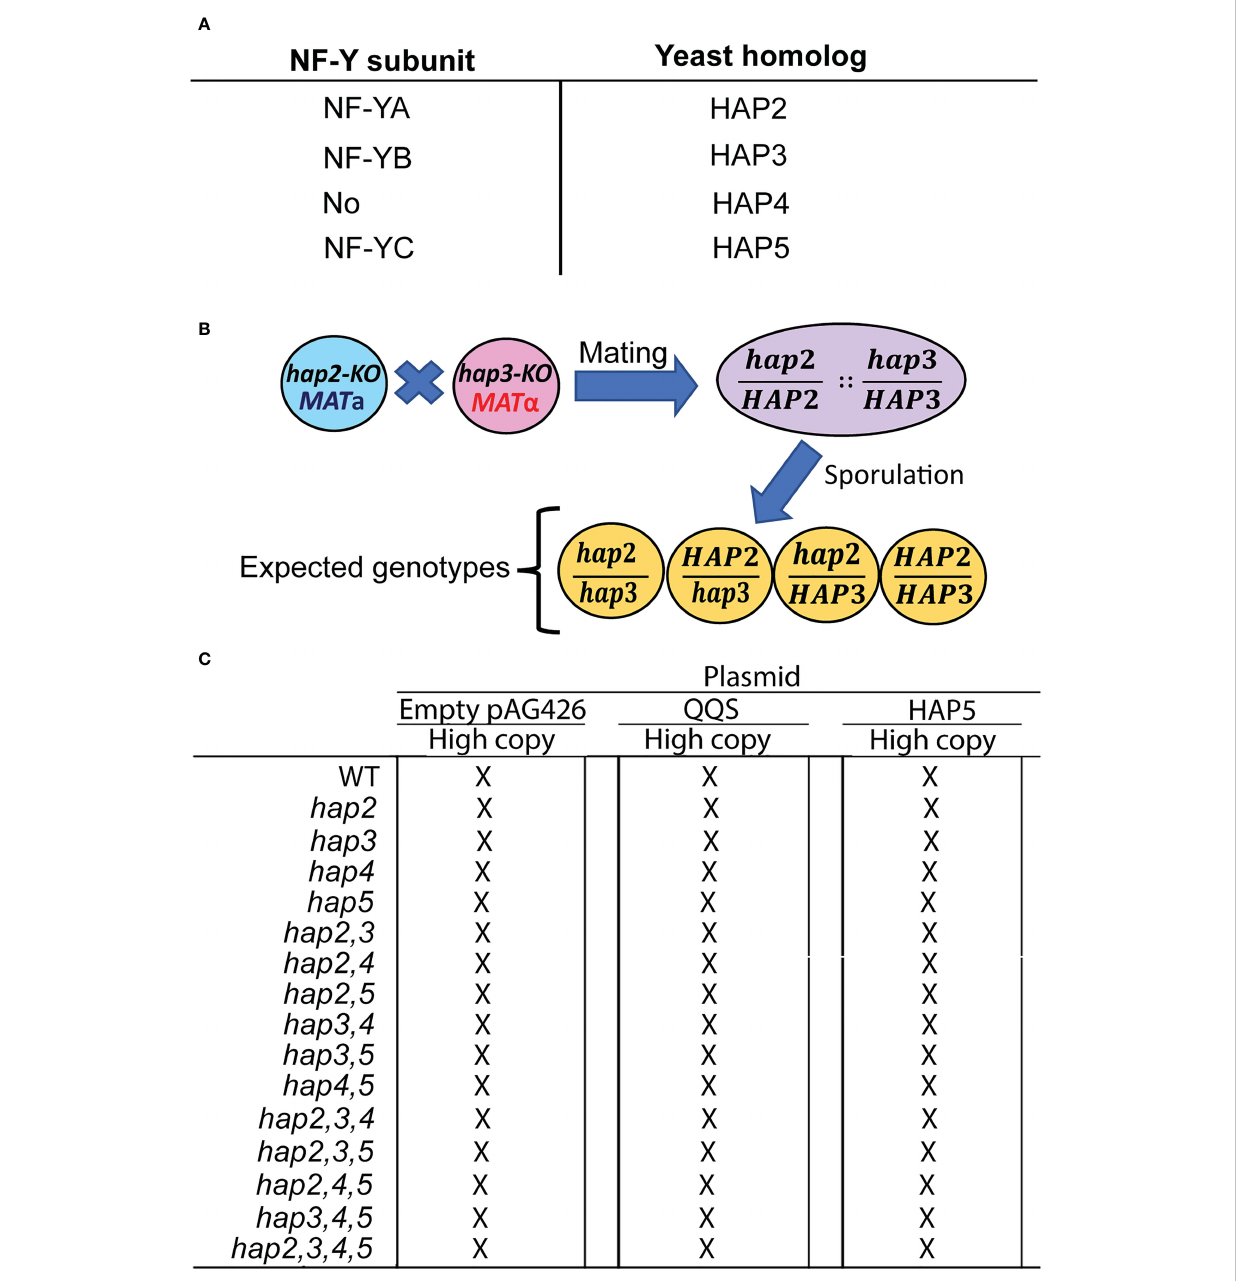
FIGURE 1 The strategy used to study the yeast HAP ( Heme-activated protein ) genes. (A) Identi fi cation of Arabidopsis NF-Y subunits and the homologous yeast HAP subunits. (B) The intermating genetic strategy for generating double mutant haploid yeast strains is exempli fi ed by the generation of the hap2hap3 double mutant strain; analogous strategies were used to generate all combinations of double, triple, and quadruple mutant strains. (C) The resulting 15 mutant strains and the WT strain were transformed with the indicated pAG426-based plasmid to generate QQS- transgenic strains ( QQS- E ) and HAP5 -overexpressing strains ( HAP5-OE